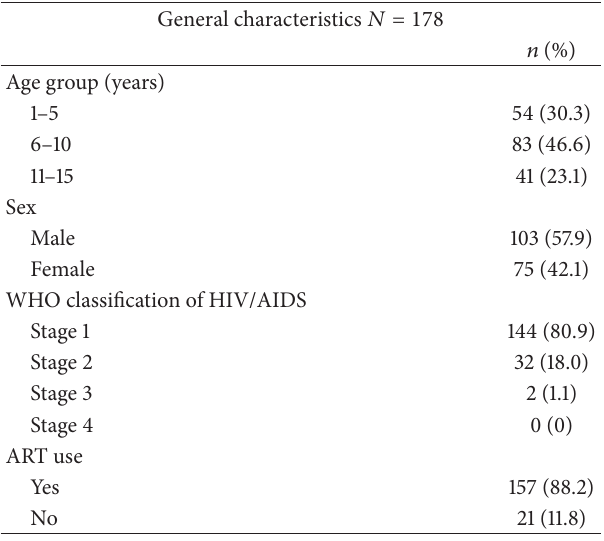
Table 1: General characteristics of the study participants.